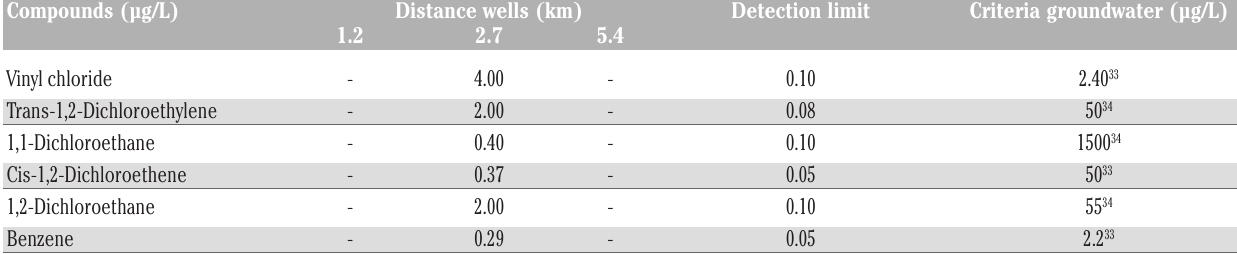
Table 2. Summary of analytical results of groundwater sites at 1.2, 2.7 and 5.4 km sampled for 61 organic contaminants (data present- ed only compounds with concentration above limit detection). Compounds